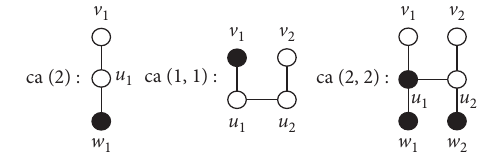
Figure 4: The symmetric caterpillar ca ( 2 ) , ca ( 1 , 1 ) , and ca ( 2 , 2